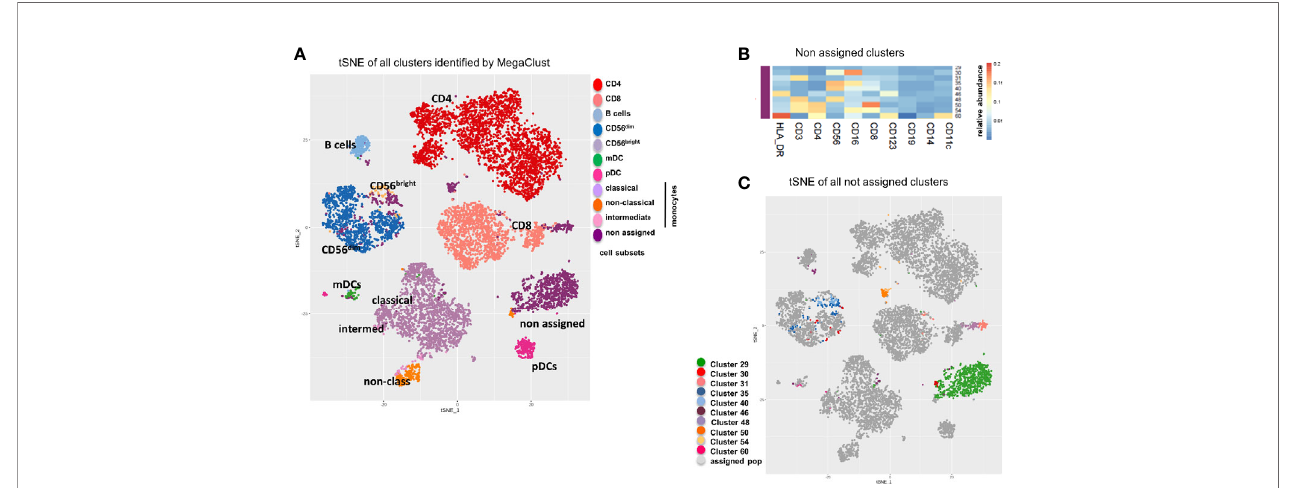
FIGURE 6 | tSNE of all clusters identi fi ed by MegaClust. (A) tSNE plot showing all clusters and populations identi fi ed by MegaClust. The different cell populations are color-coded and listed on the right. One group contains clusters of cells that where not assigned. (B) Cumulative analysis on all patients and timepoints (n=20) of the expression level (mean fl uorescence intensity, MFI) of different markers on the 10 unassigned clusters. (C) tSNE plot showing all clusters and populations identi fi ed by MegaClust, with the 10 clusters identi fi ed by MegaClust that could not be assigned to known reference populations highlighted with distinct